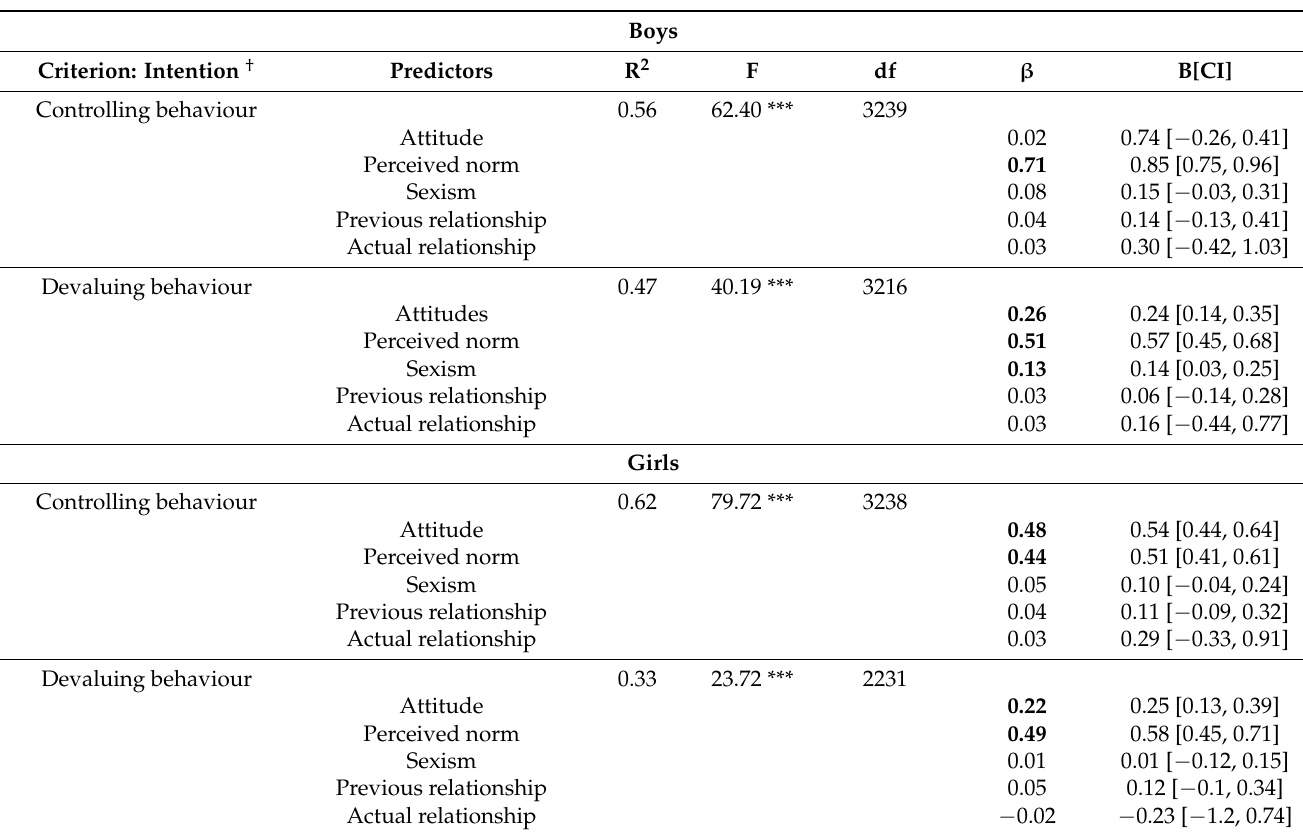
Table 2. Predictive models of intention to perform and accept the behaviours in the study with single